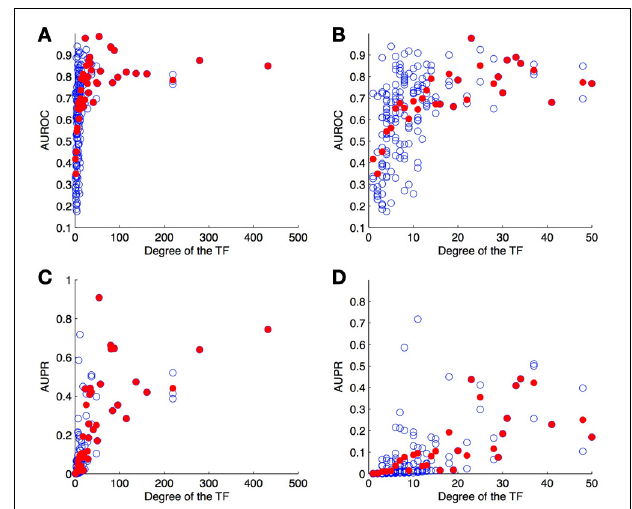
FIGURE 6 | AUROC (A,B) and AUPR (C,D) for each TF as a function of its degree (number of targets) on the DREAM5 network. Each value was obtained by 10-fold CV on genes. Each blue point corresponds to a particular TF and plots its average AUROC or AUPR value over the 10-folds. Each red point correspond to the average AUROC or AUPR values over all TFs of the corresponding degree. Globally, the higher the degree, the higher are the areas under the curve and so the better are the